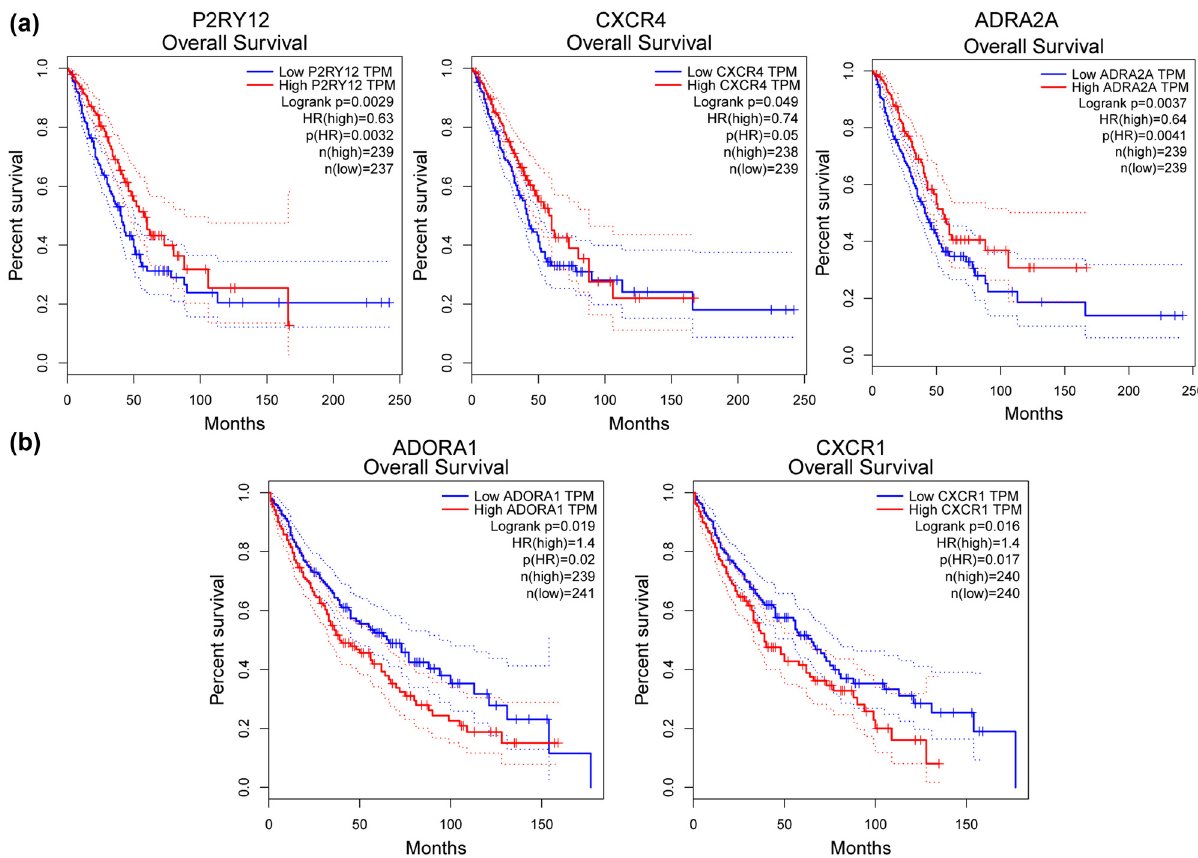
Figure 7: The lung cancer prognosis - related genes in ALI. The LUAD and LUSC data in the GEPIA online tool ( http://gepia.cancer - pku.cn/ ) were employed for the survival analysis. ( a ) LUAD and ( b )